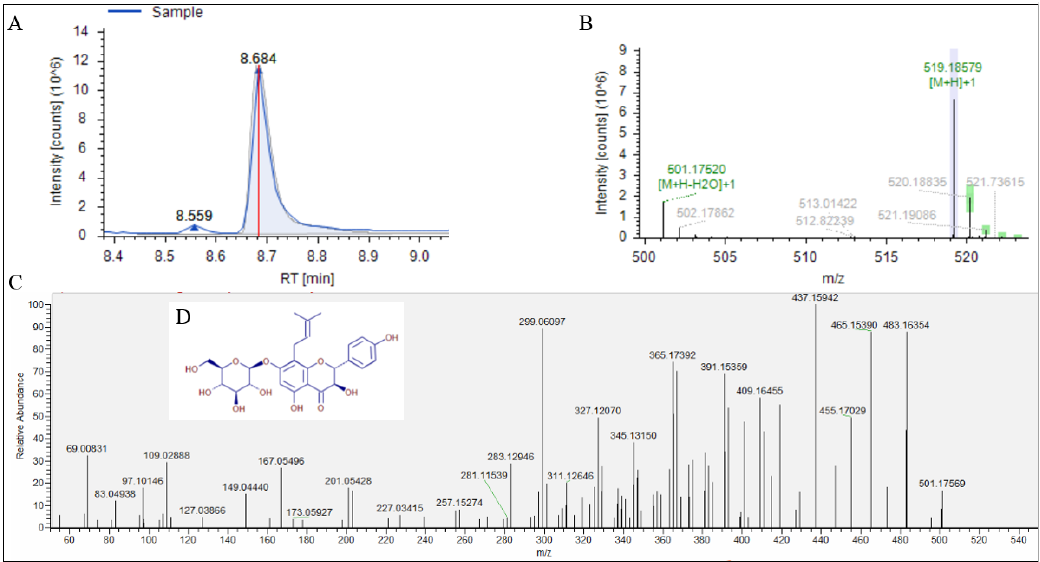
Figure 3. Analysis of No.1. ( A ) chromatogram of No.1. ( B ) parent ion and isotope. ( C ) The MS 2 spectrum of parent ion m / z 519.18579. ( D ) Structure of phellamurin.